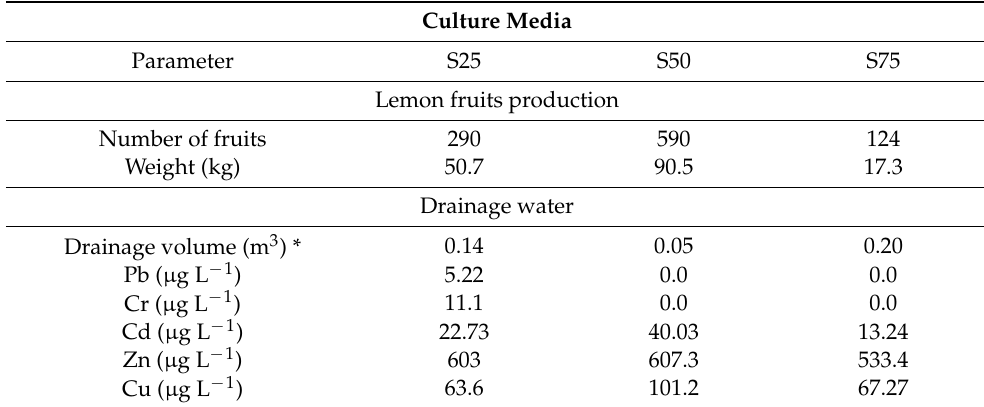
Table 3. Experimental data used in the LCA study of port sediment as a culture media for ‘Verna’ lemon